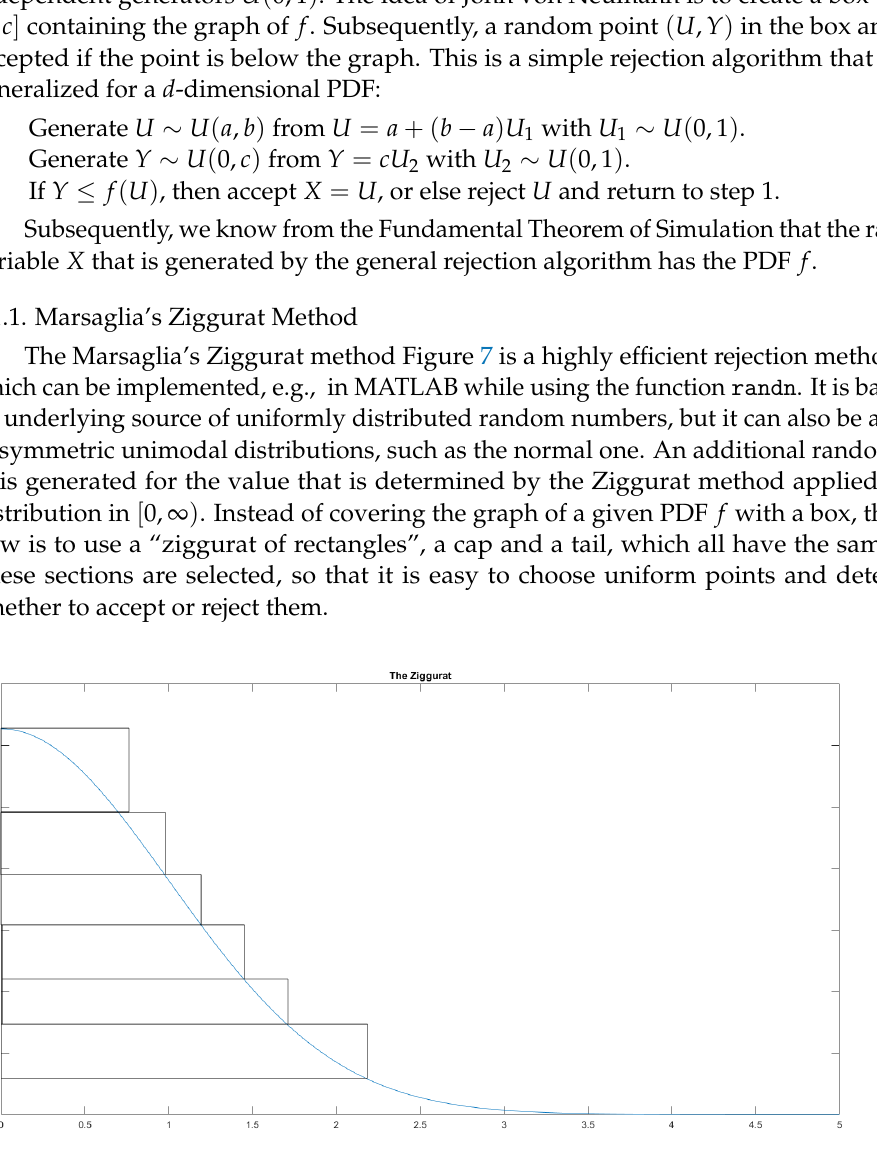
Figure 7. The Ziggurat basic